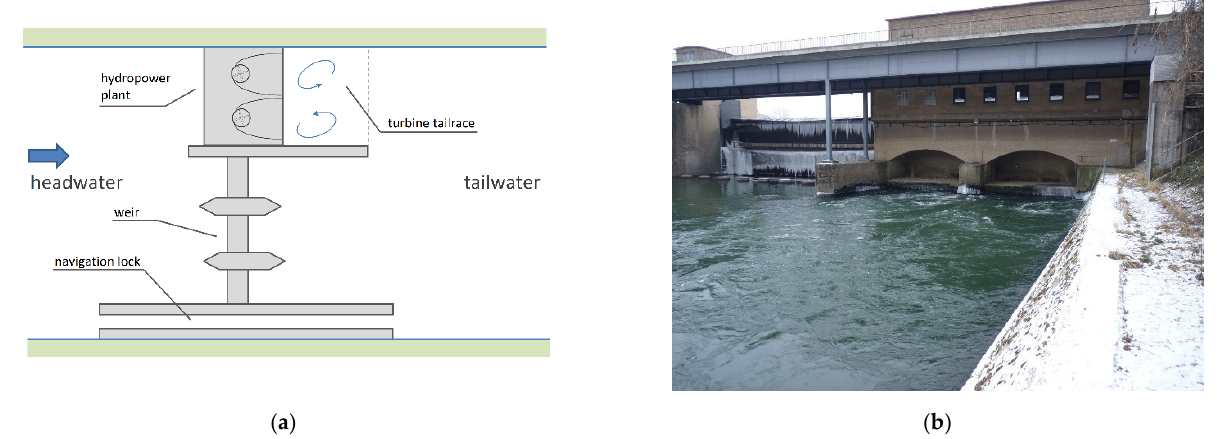
Figure 1. ( a ) Typical scheme of a hydropower dam at federal waterways in Germany. ( b ) Photograph of turbine tailrace of Lauffen (Neckar River, Germany).